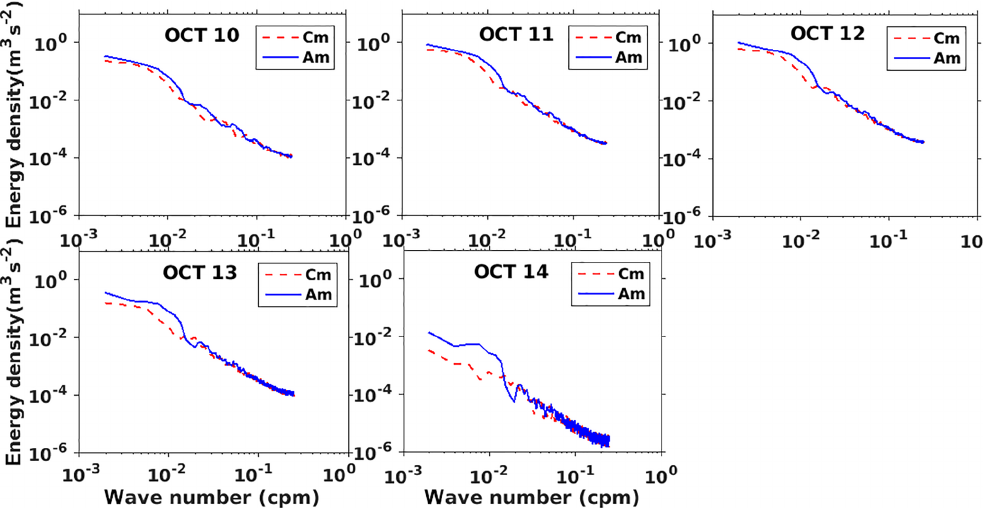
Figure 10. The daily averaged vertical wave-number rotary spectra of near-inertial oscillations. The anticyclonic and cyclonic spectra are represented by blue and dotted red lines, respectively.